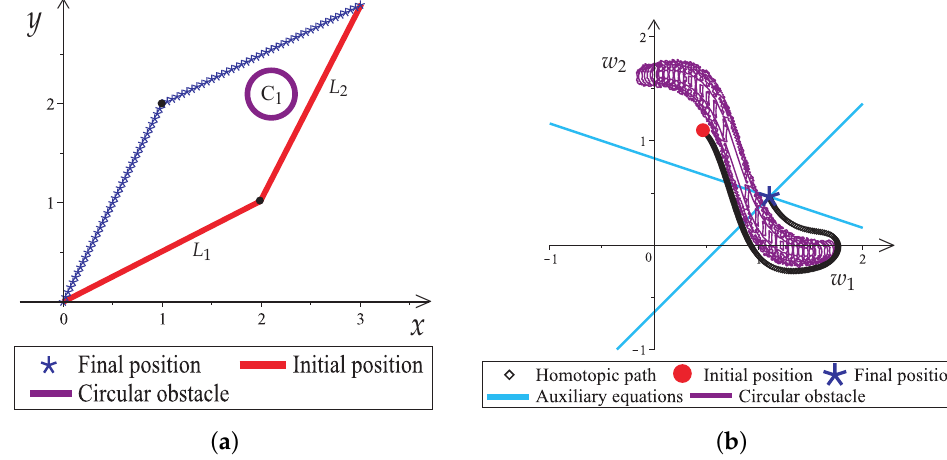
Figure 7. Workspace to C-space of a two-link planar robot arm with a circular obstacle. ( a ) Two-link planar robot workspace. ( b ) C-space representation of the two-link planar robot